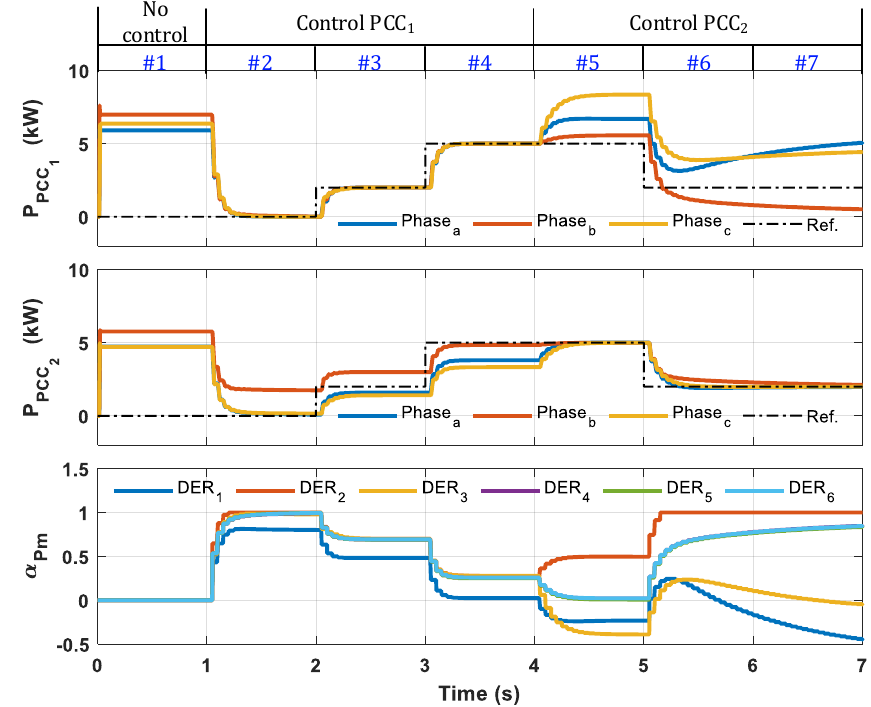
Figure 7. Active power in PCCs and scalar coefficients (𝛼 𝑝𝑚 ) for MPBC.